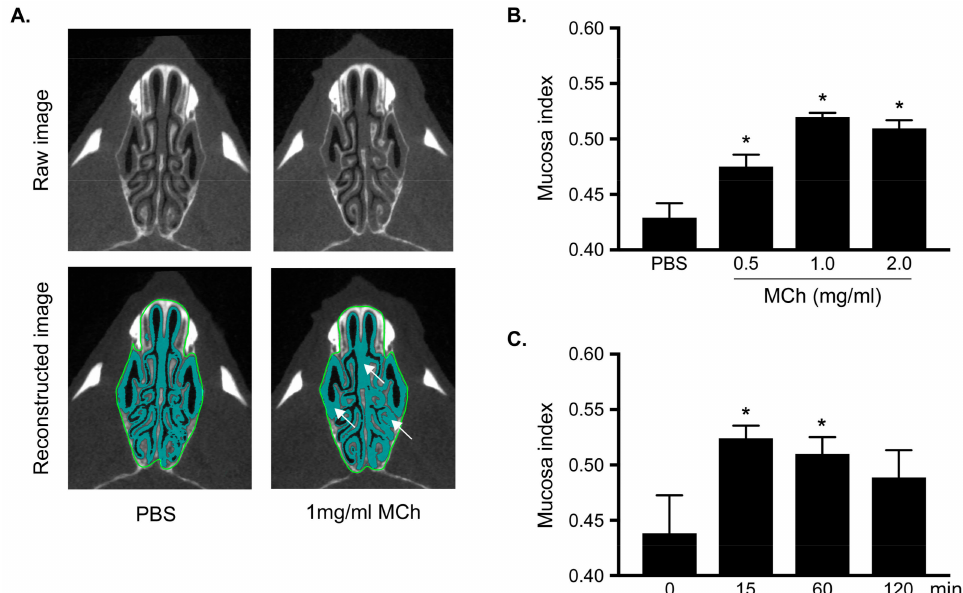
Figure 2. Analysis of swelling of nasal mucosa using micro-CT images in axial axis ( A ), Upper and Lower panels indicate raw and reconstructed selected ROI images, respectively. Left and right panels indicate observations 15 min after PBS and 1 mg / mL methacholine (MCh) treatments, respectively. ( B ) and ( C ) show dose-dependent and kinetics analyses, respectively. Mucosa index was analyzed 15 min after PBS or 0.5–2.0 mg / mL MCh treatment ( B ) or 0, 15, 60, and 120 min after PBS or 1 mg / mL MCh treatment ( C ). Data are expressed as means ± standard errors of mean (SEMs) ( n = 3–6 for each